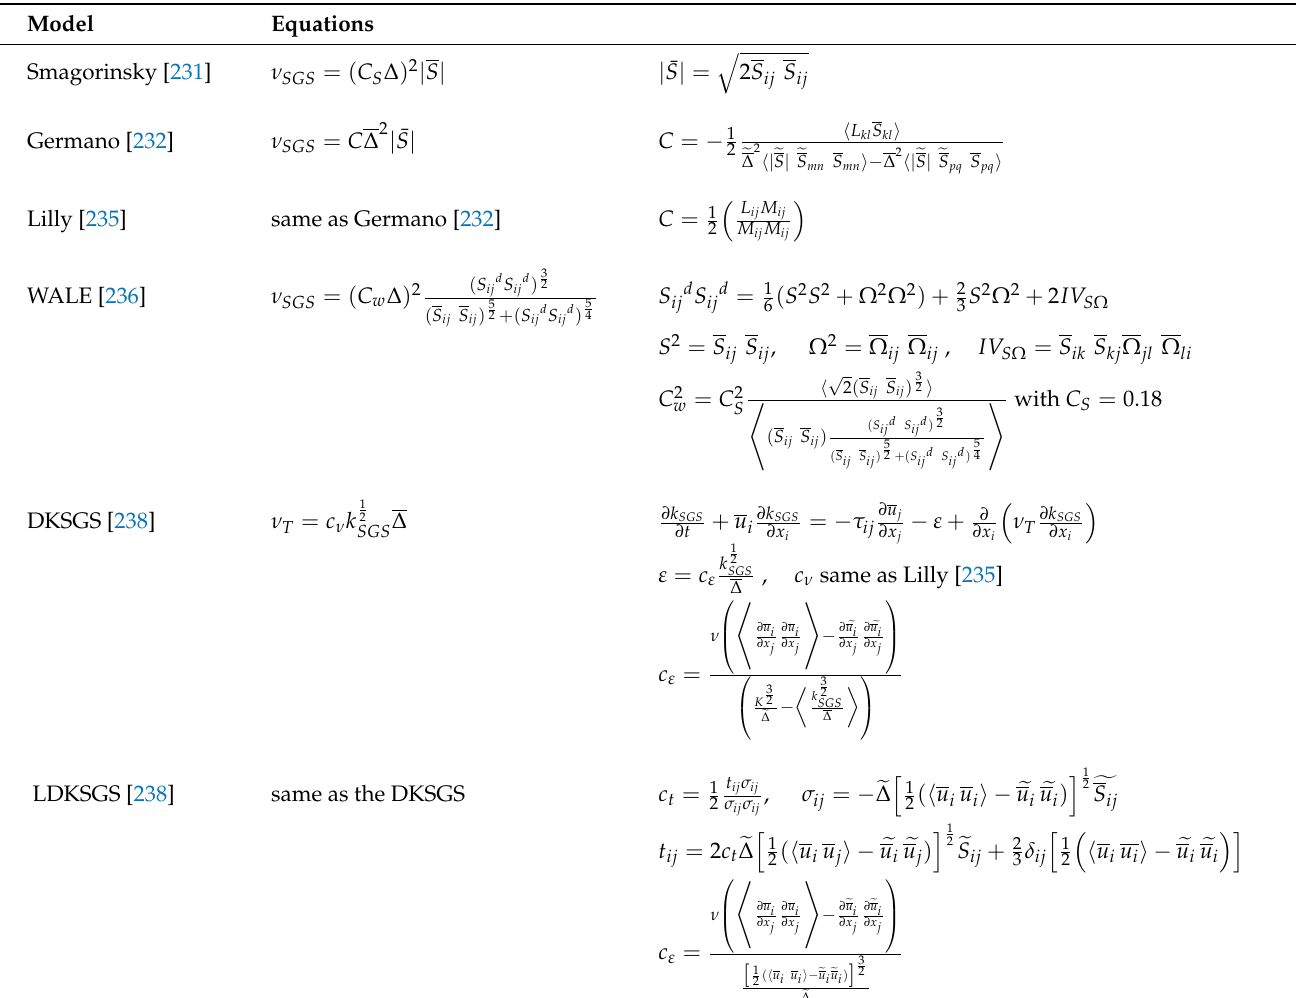
Table 6. Overview on LES turbulence